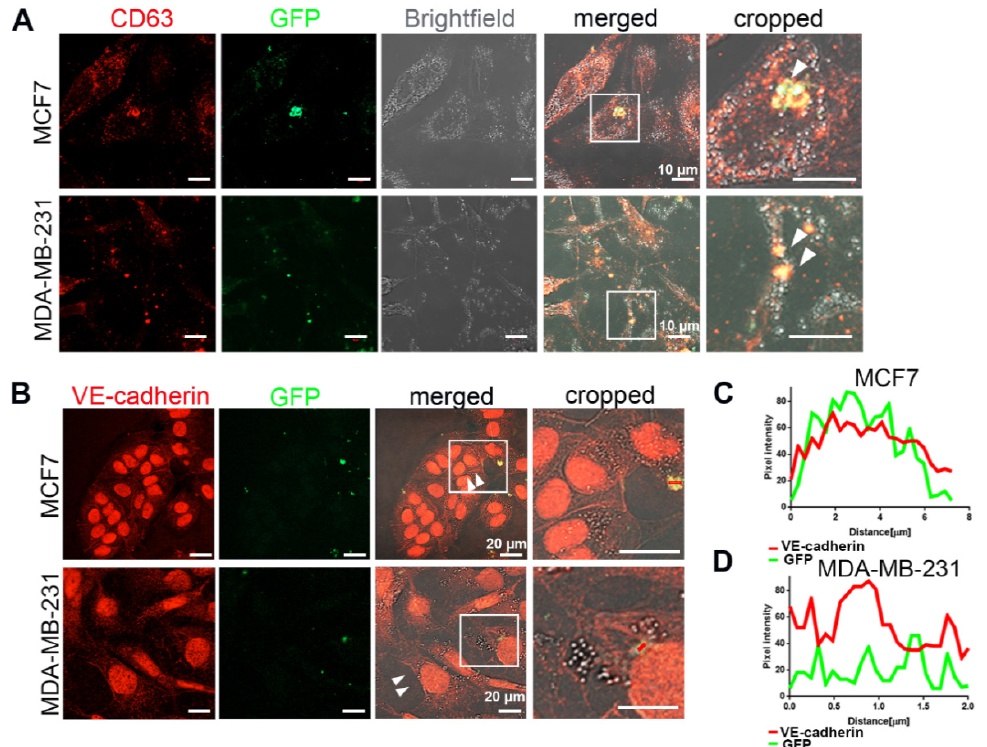
Figure 6. VE-cadherin was transferred from ECs to cancer cells via EVs. ( A ) After 6 days of co-culturing MCF7-mCherry or MDA-MB-231-mCherry with GFP-labeled HUVECs, the extracellular vesicles were isolated from conditioned medium with Exo-spin column and added to MCF7 or MDA-MB-231 monoculture. White arrows showing CD63-GFP vesicles inside the breast cancer cells indicate the exosome transfer from HUVEC-GFP to cancer cells. ( B ) Incubation of MCF7 (upper panel) or MDA-MB-231 (lower panel) cells for 5 days with the EVs isolated from co-culture supernatant induced VE-cadherin (red) expression and its recruitment at the junctions (arrows) in breast cancer cells. ( C , D ) Line scan (red bars) from images of ( B ) quantifying the presence of VE-cadherin and GFP signal in the EVs derived from GFP-labeled HUVECs after being internalized by ( C ) MCF7 and ( D ) MDA-MB-231 cells.